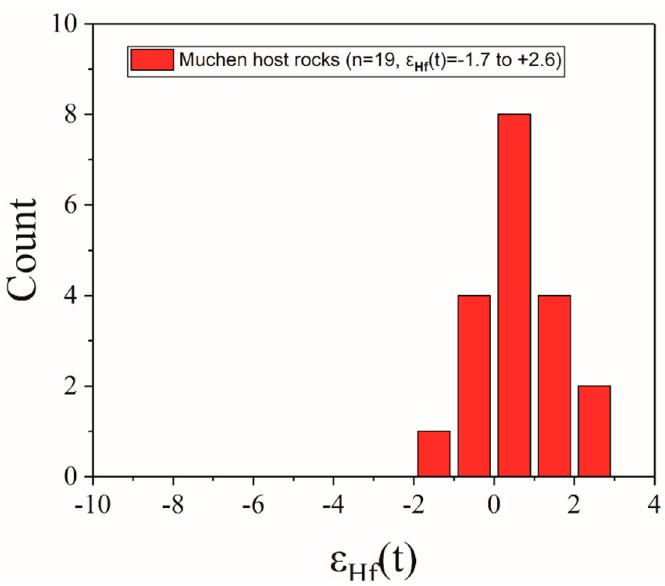
Figure 6. Histograms of ε Hf ( t ) values for zircons from representative Muchen alkaline quartz monzonite.